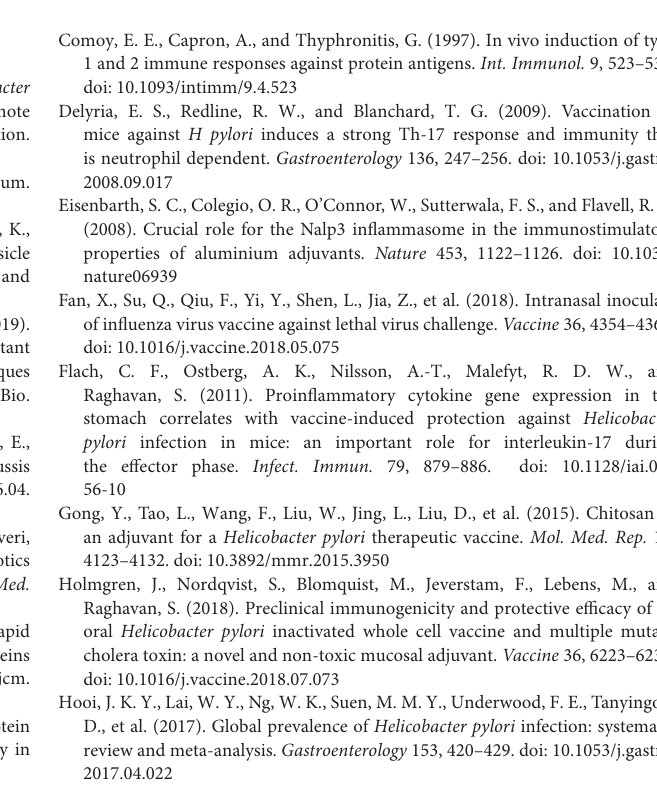
FIGURE S1 | Concentrations of anti- Hp OMP secretory-IgA (S-IgA) within 12 weeks of the first immunization which were quantified by ELISA. Each cohort contained 18 mice. These data reflect S-IgA levels severally in vaginal secretion specimen from immunized mice. Group immunized with OMP, WCV, or OMVs derived from H. pylori 7.13 served as negative control to discount the interference of vaccine effect. Statistical significance was assessed by two-way ANOVA test. P < 0.01 was considered as statistically significant. All the results were expressed as means ± SD per